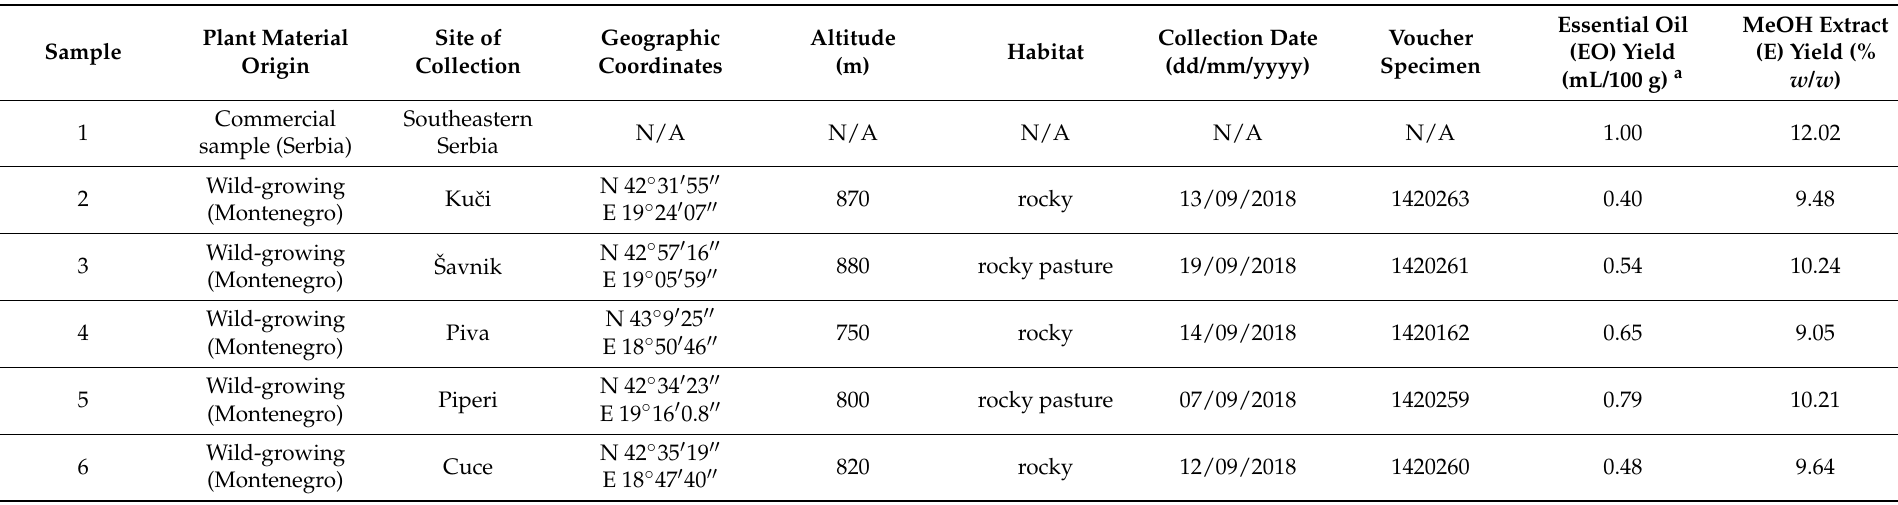
Table 1. Plant material: origin, collection data and yields of essential oils and extracts. a Values are the means of five consecutive determinations.